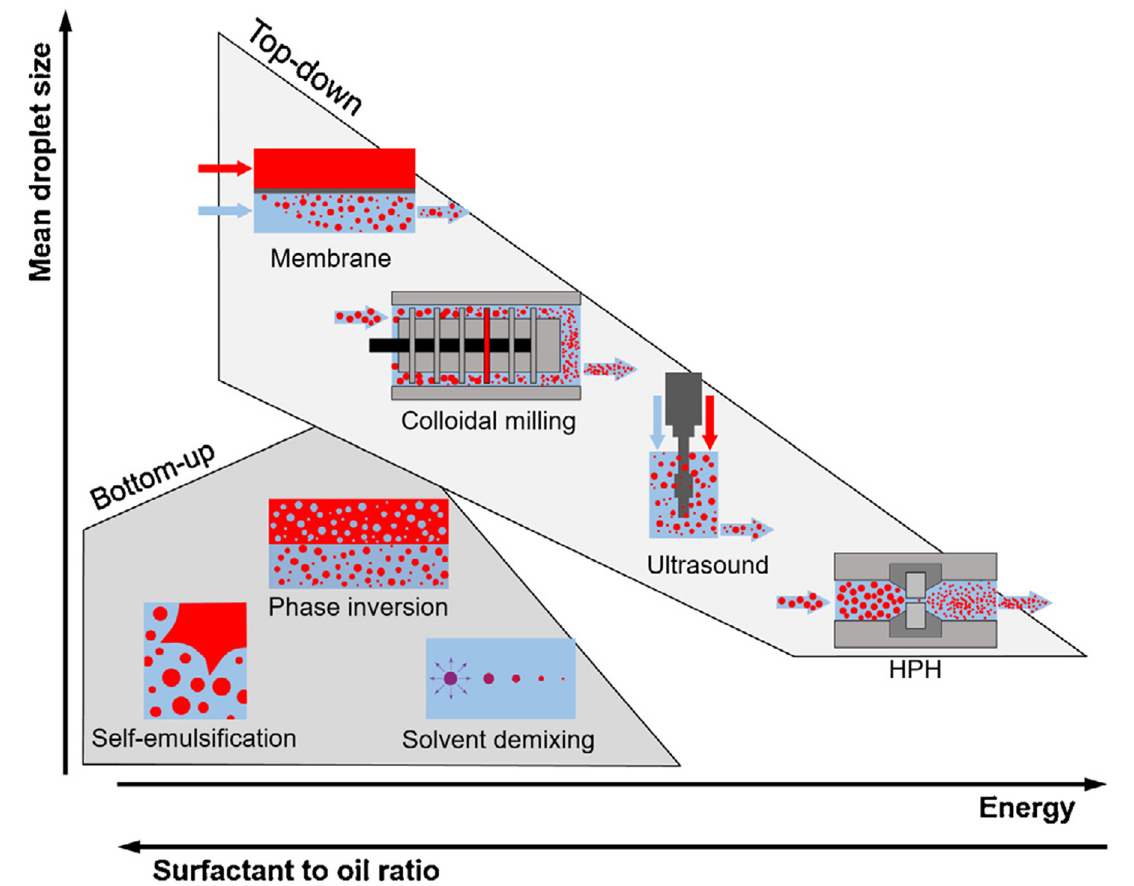
Figure 2. Top–down and bottom–up approaches (reproduced with permission) [181].